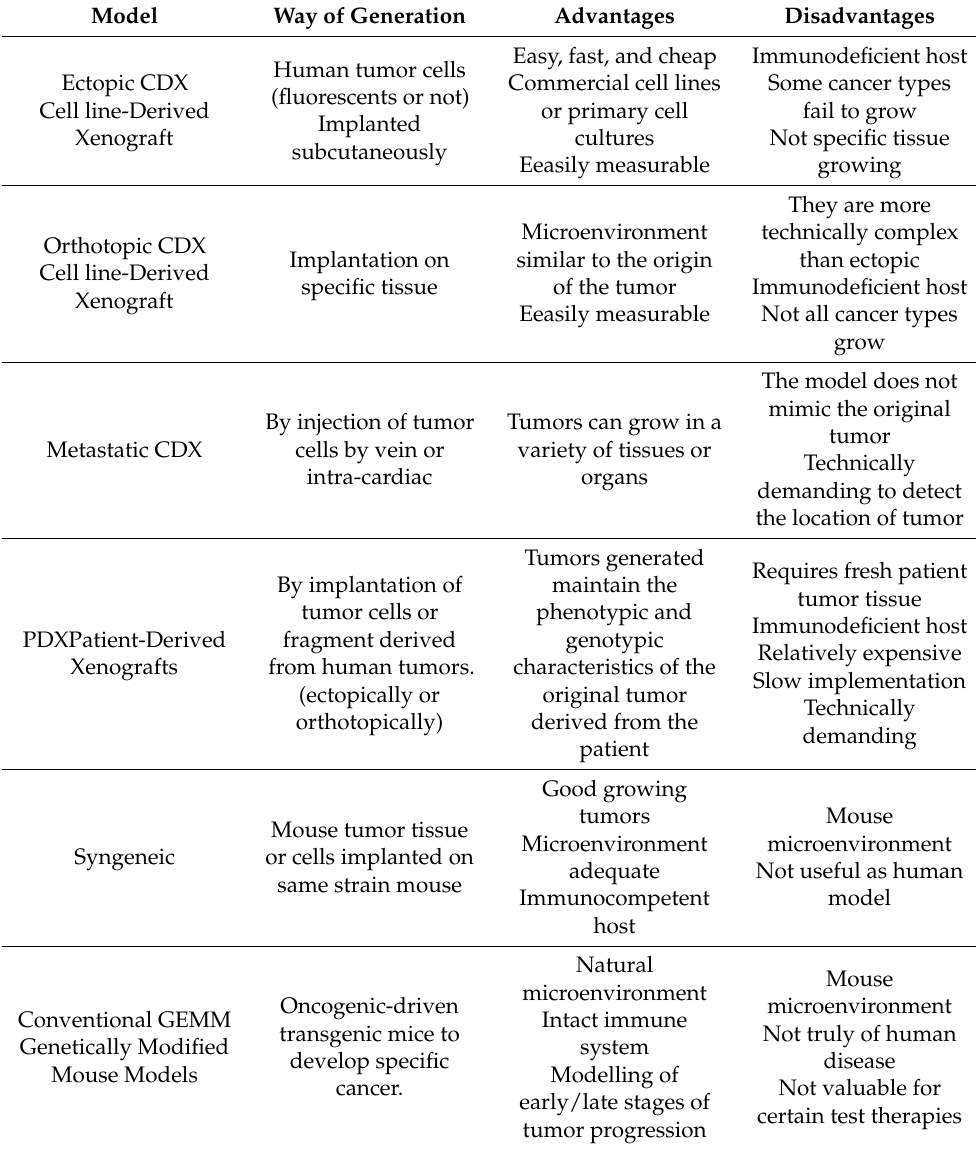
Table 3. Advantages and disadvantages of different murine models used cancer research. Adapted from [166], published by The Company of Biologists,